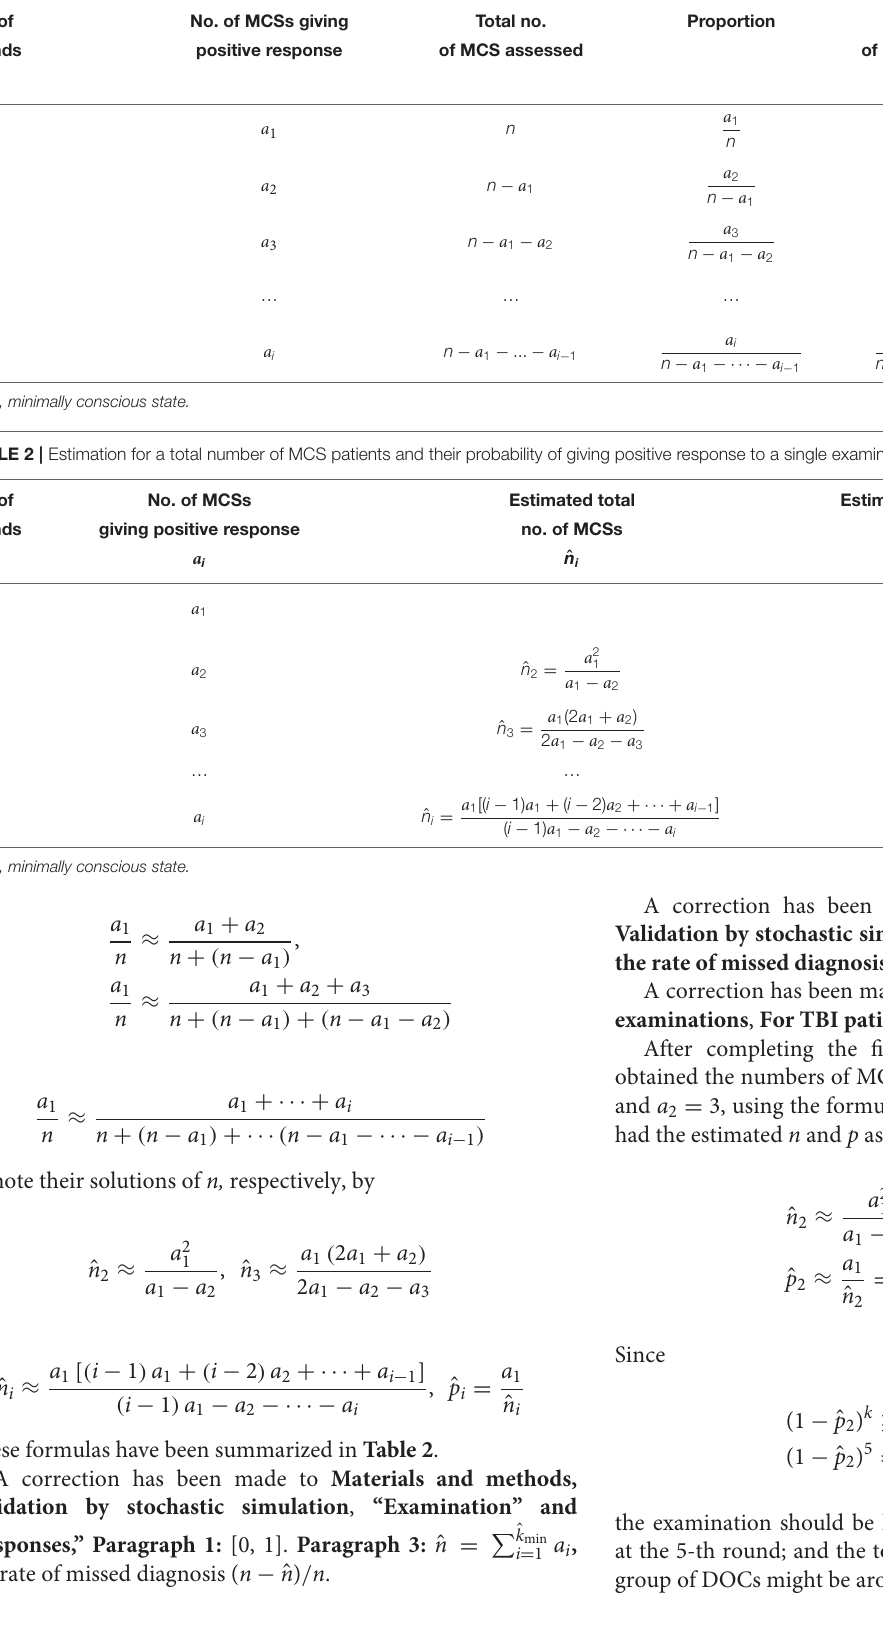
TABLE 1 | Pooled estimate for the probability of positive response to a single examination given by an MCS patient in theory. No. of No. of MCSs giving Total no. Proportion Pooled estimate for the probability rounds positive response of MCS assessed of positive response to a single examination